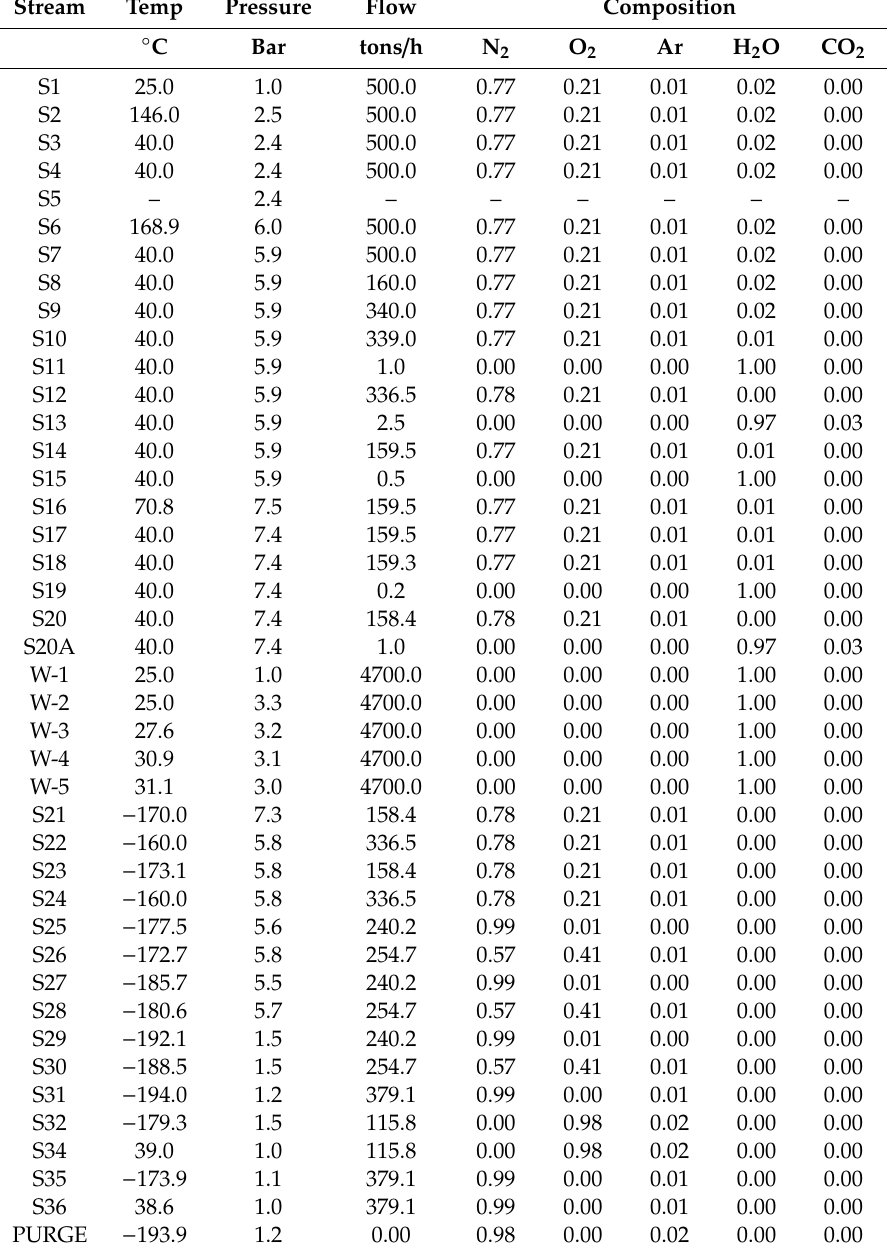
Table 2. Steady-state simulation results for the ASU configuration